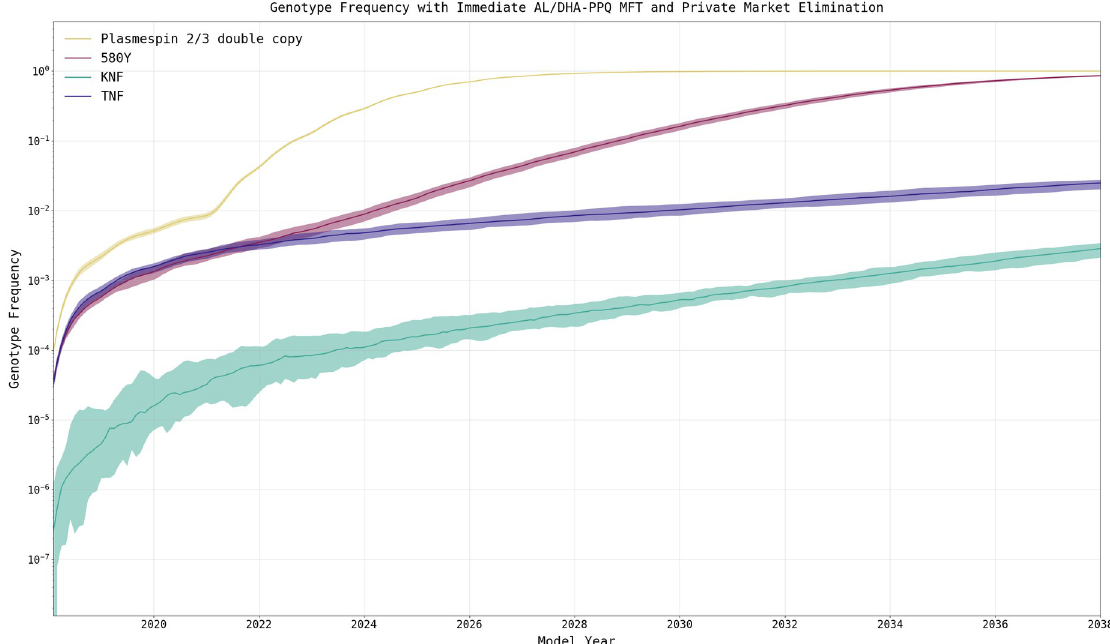
Fig 7. Increase of plasmepsin-2 , 3 double-copy genotypes under immediate private-market elimination and immediate MFT (median and 95% range). The rapid elimination of the private market coupled with introduction of MFT (in model year 2021) serves as an exemplar of the rapid increase in double-copy plasmepsin-2 , 3 genotypes after DHA-PPQ is introduced at high levels in 2021. Double-copy plasmepsin-2 , 3 genotypes (yellow) are strongly selected for after DHA-PPQ is introduced, which contrasts with the slower pace of 580Y evolution (magenta). This rapid increase in the frequency of the double-copy plasmepsin-2 , 3 genotypes result from the low efficacy of DHA-PPQ on these genotypes (77% efficacy on C580 and 42% on 580Y). KNF genotypes (green) show the most resistance to lumefantrine, but the efficacy of AL on KNF genotypes is 89% (C580) or 72% (580Y) making the selection pressure exerted by AL weaker than the selection pressure exerted by